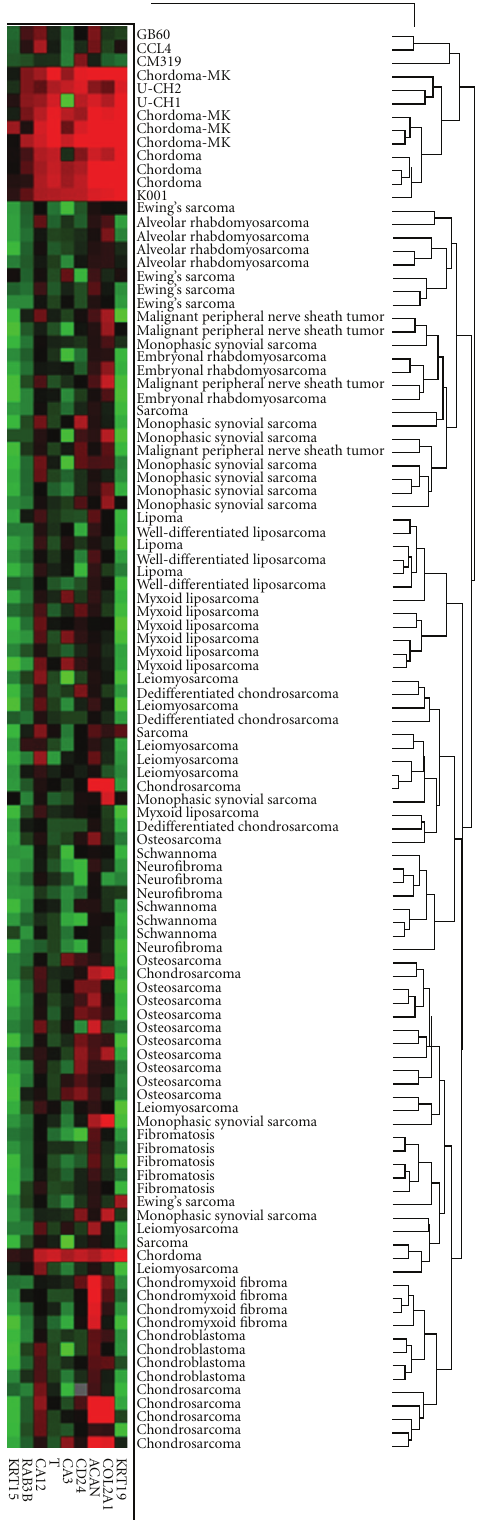
Figure 3: Gene expression analysis of chordoma tumors, cell lines, and mesenchymal tumors. Five chordoma-specific genes from among the 1208 probe sets used for cluster analysis are included; T: brachyury, KRT19: keratin19, Col2A1: collagen 2A1, CA3: carbonic anhydrase 3, and CD24. Genes with decreased relative expression are shown in green while those with increased relative expression are shown in red. Chordoma tumors (chordoma and chordoma-MK) and cell lines U-CH1, U-CH2, and K001 have a similar expression patterns distinct from the other putative chordoma cell lines and other